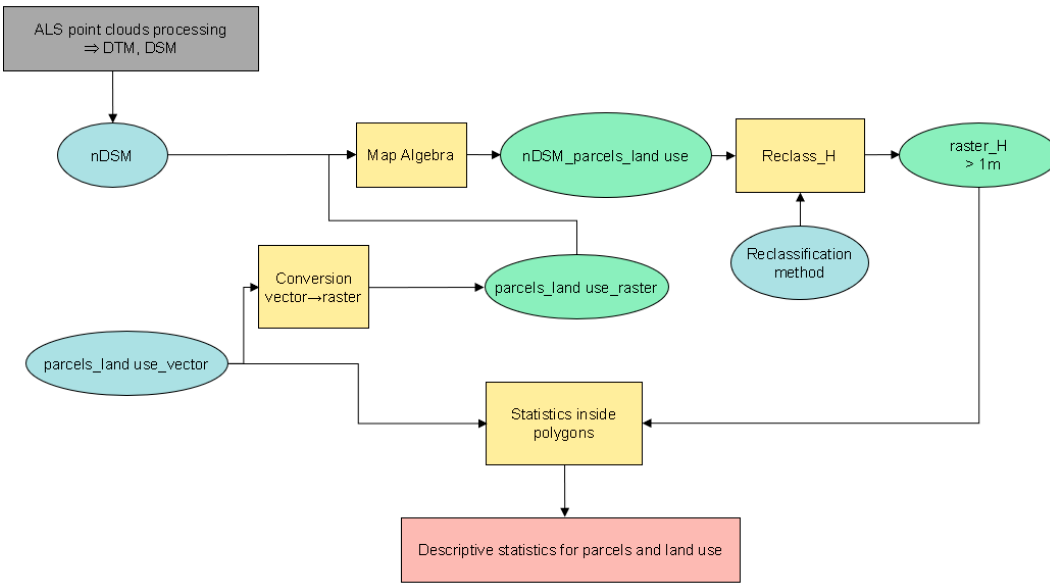
Figure 2. Scheme for the analyses (normalized digital surface model (nDSM) > 1.0 m) of individual plots according to land use [23,24].